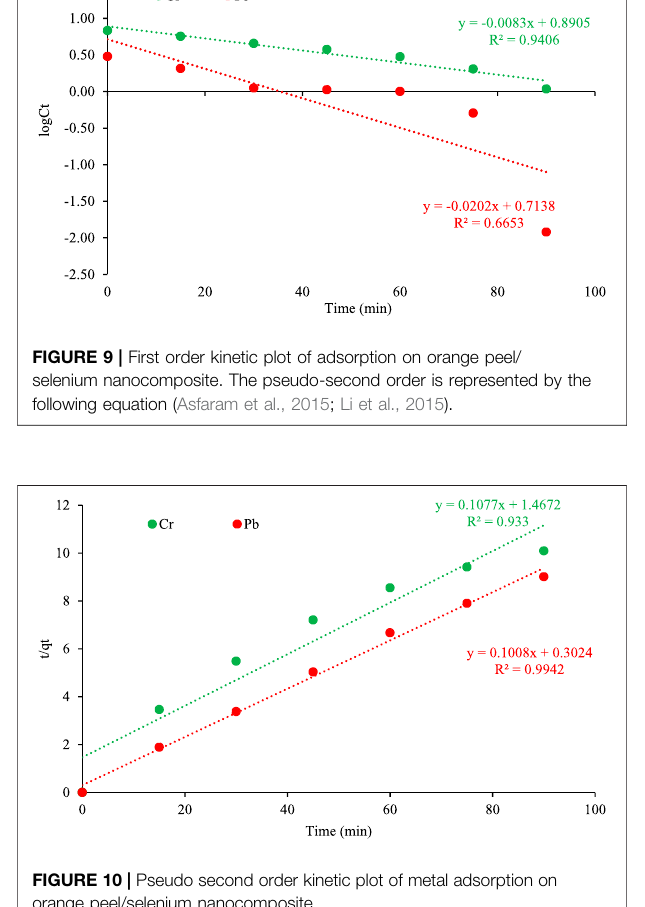
Frontiers in Environmental Science |